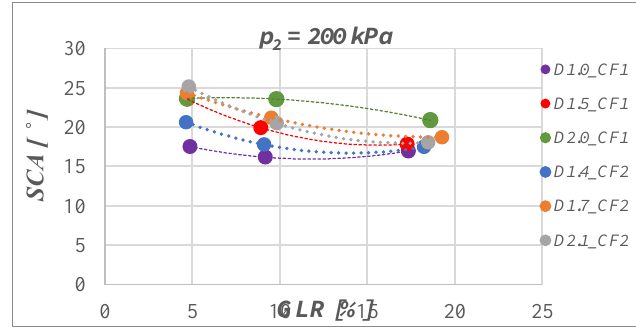
Fig. 10. The influence of GLR on SCA for p 2 = 100 kPa